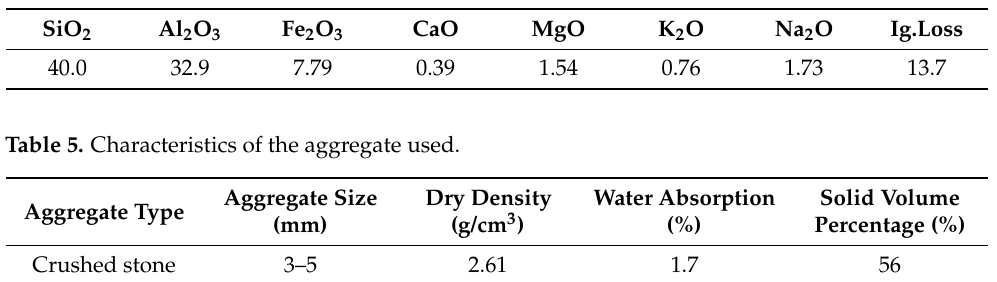
Table 4. Chemical components of red clay (%).